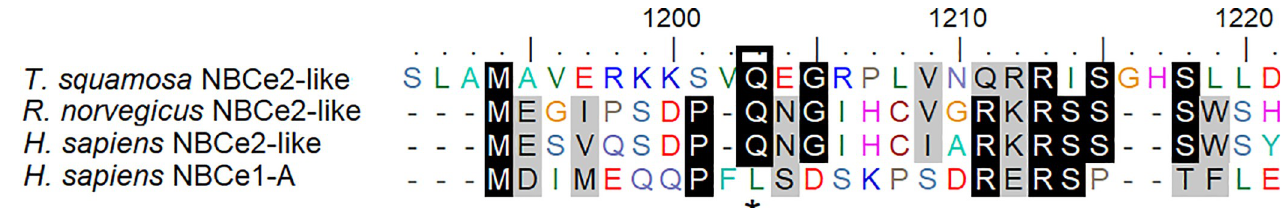
Fig 2. An aligment of the partial sequence of a homolog of electrogenic Na + -HCO 3 − cotransporter 2 (NBCe2-like protein) obtained from the outer mantle of Tridacna squamosa with the partial sequences of NBCe2 of Rattus norvegicus (NP_997677.1) as well as NBCe2 (AAK26741.1) and NBCe1-A (NP_003750.1) of Homo sapiens in order to examine the basolateral targeting motif. Similar/identical amino acid residues are shaded. The asterisk indicates the coordinating residue for the basolateral targeting motif of NBCe1-A from human. The absence of the basolateral targeting residue in NBCe2-like of T . squamosa , as well as NBCe2 of R . norvegicus and H . sapiens , is highlighted by a box.